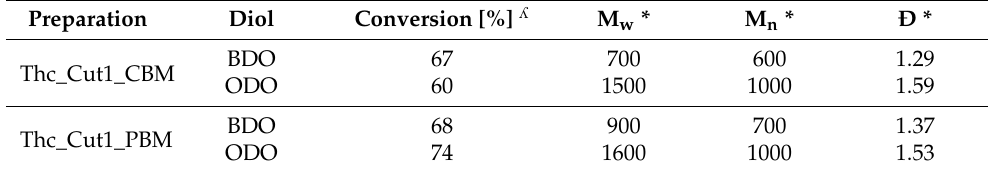
Table 3. Polycondensation of DMA with various diols by different covalently-immobilized cutinases fused with binding modules at 24 h at 50 ◦ C and 1000 mbar, using 10% w w − 1 of biocatalyst. Preparation Diol Conversion [%] L M w * M n * Ð * BDO 67 Thc_Cut1_CBM